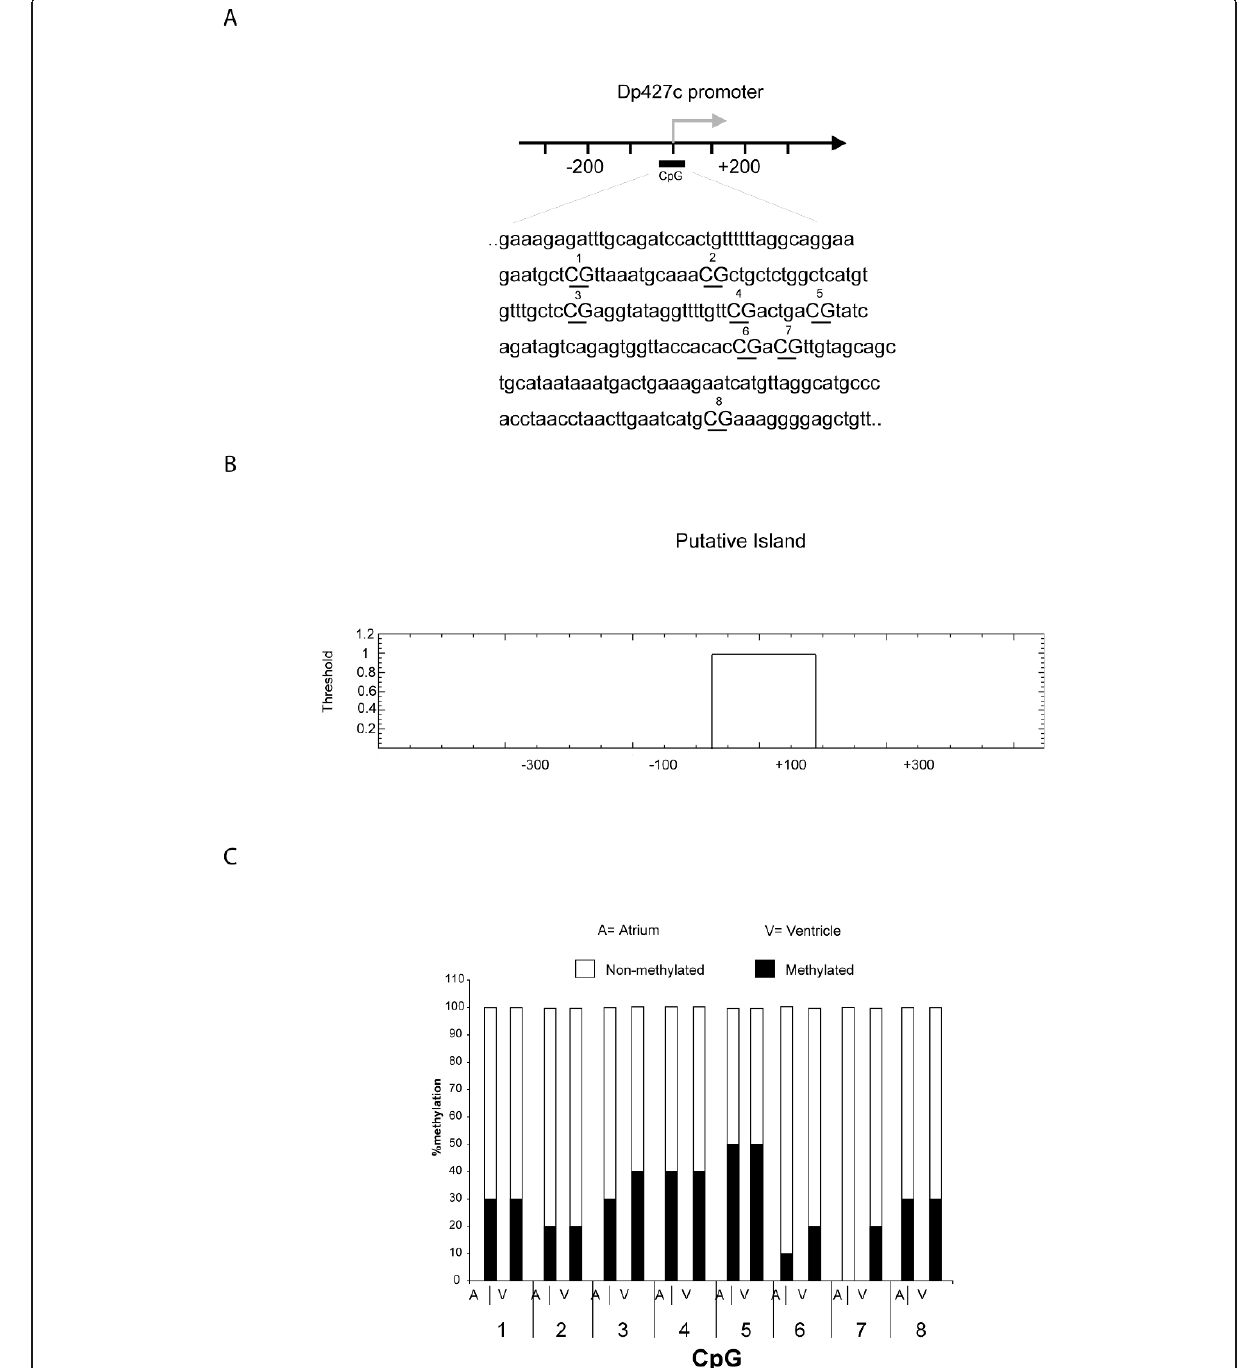
Figure 4 Methylation status of the B promoter CpG islands in heart ventricle and atrium . A) Schematic representation of the B isoform (Dp427c) promoter. Grey arrow indicates the transcription start site of the Dp427c mRNA. The DNA sequence and distribution of the CG dinucleotides is shown B) Prediction of the putative CpG island in the B promoter using the Emboss CpGplot algorithm C) Percentage of methylated cytosines within the putative CpG island in DNA extracted from ventricle and atrium muscle tissue,